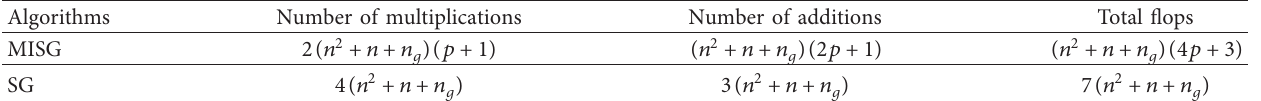
Table 3: Comparison of the computational efficiency of the MISG and the SG algorithms.